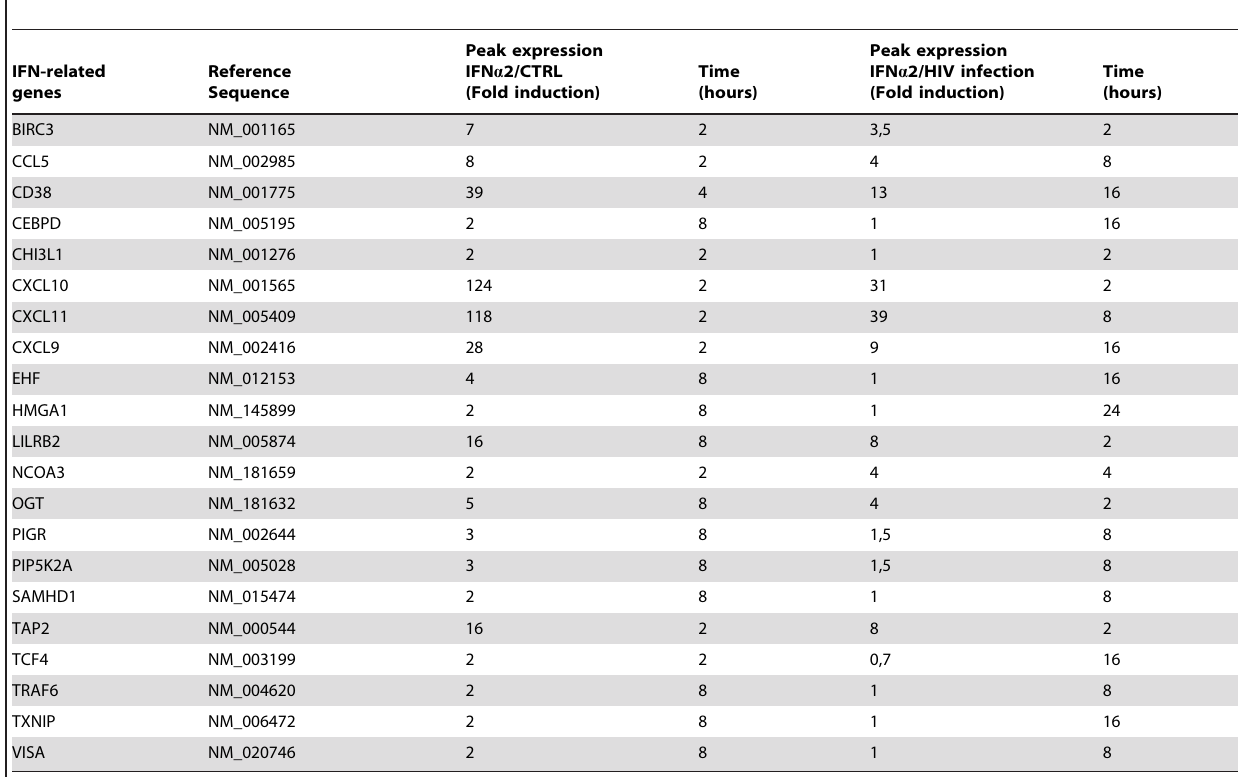
Table 3. Peak expression and time point of candidate genes associated with IFN response that were modulated in IFN a 2 pre- treated macrophages compared to untreated control and modulated by